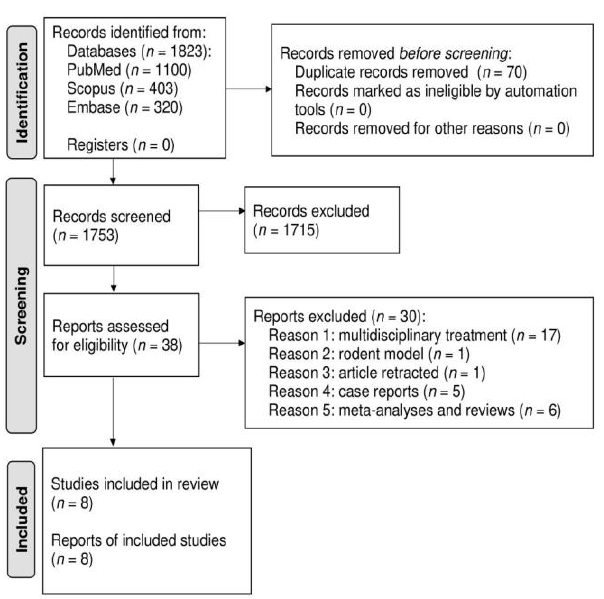
Figure 1. PRISMA flow diagram for search strategy results and eligibility criteria.